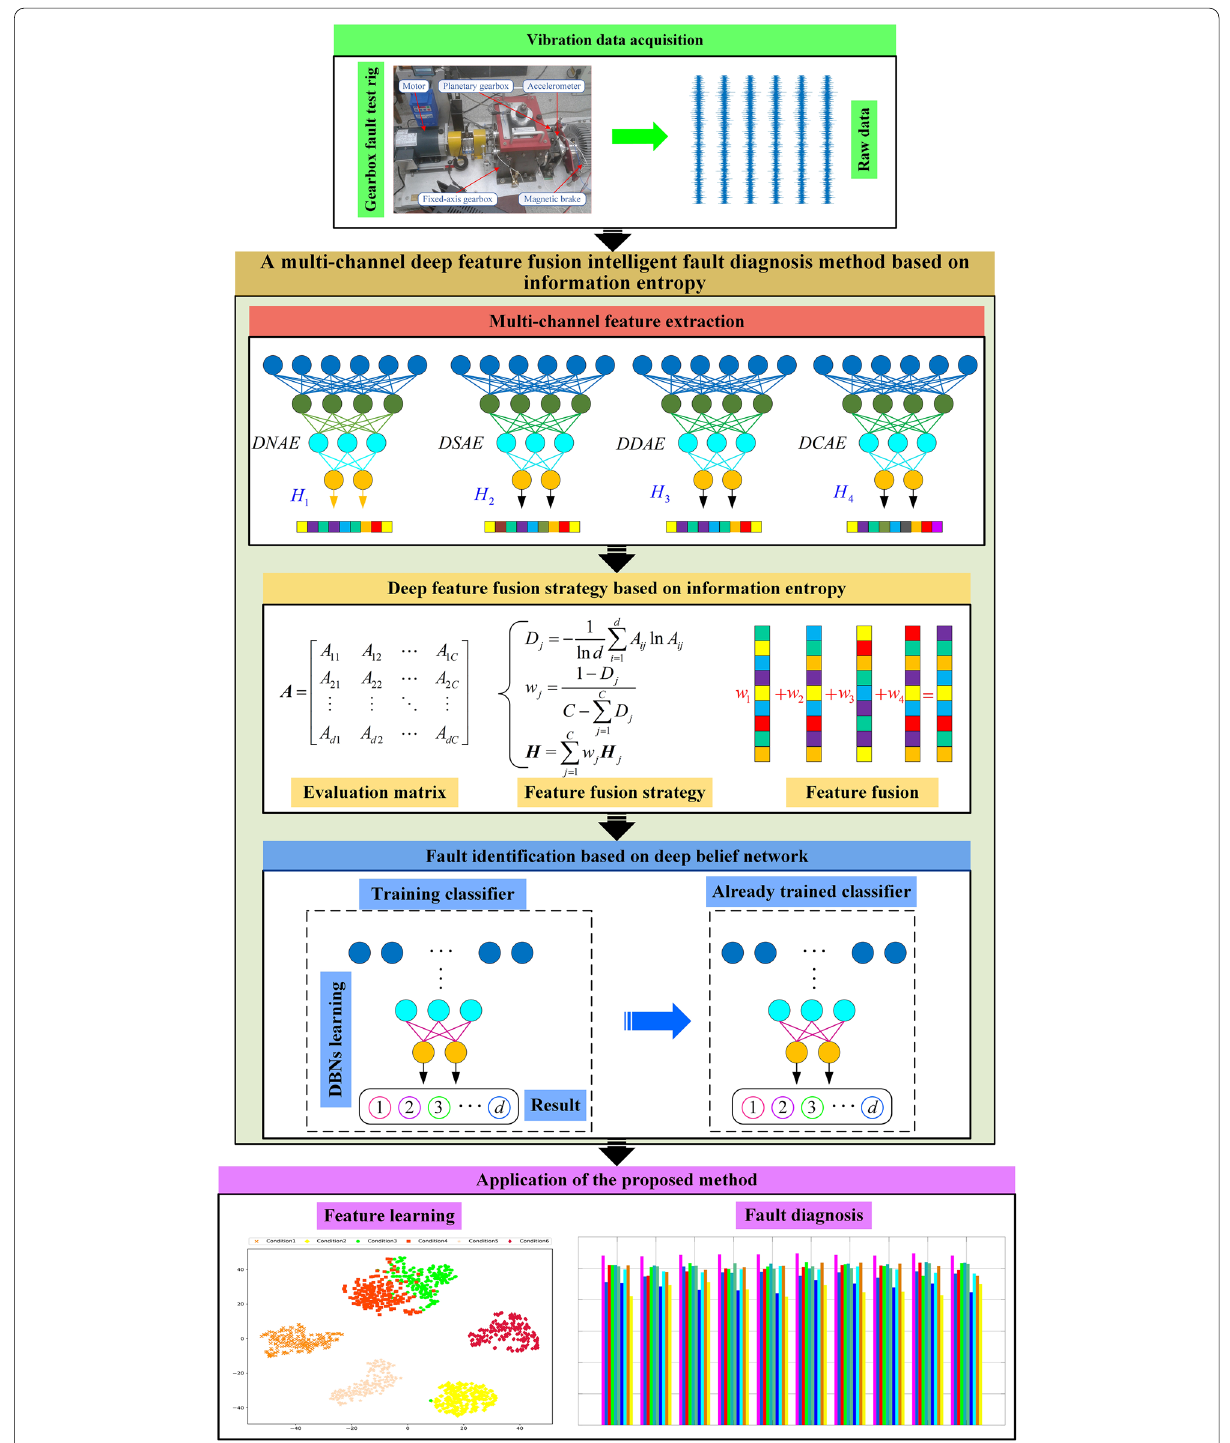
Figure 5 The proposed method implements a framework for fault diagnosis of